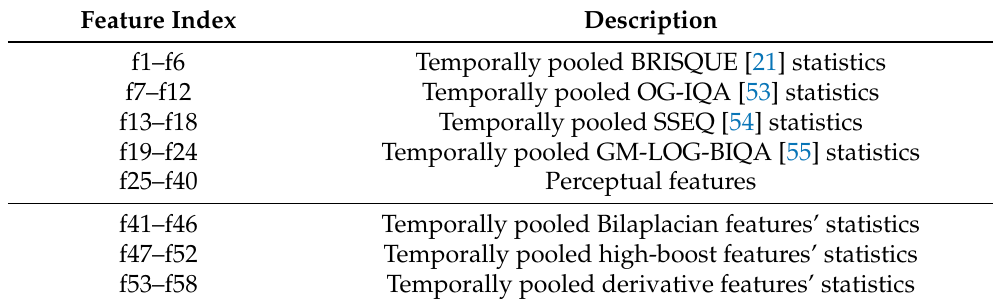
Table 1. Description of features introduced in our method.